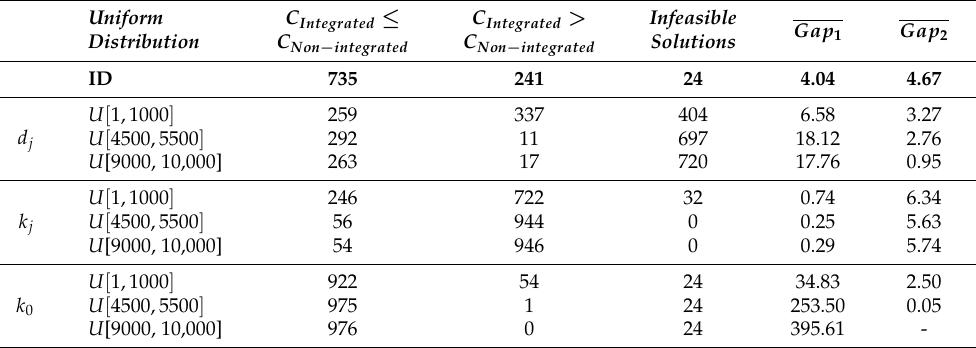
Table 7. Comparison between the integrated and the non-integrated policies. In columns 3–4, the number of instances where the integrated strategies outperform the non-integrated policies, and vice versa, are